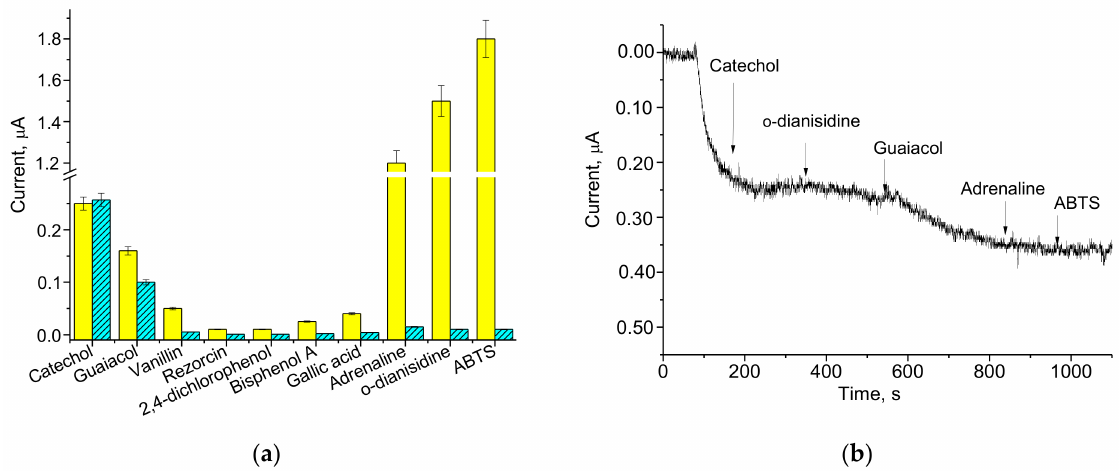
Figure 5. The selectivity tests for laccase/CuCo/GEs, which were covered with Nafion ( a , yellow) or with DM ( a , cyan; b ): the current responses on the added analytes up to 0.2 mM concentration in the individual solutions ( a ) and in the mixture of sequentially added compounds ( b